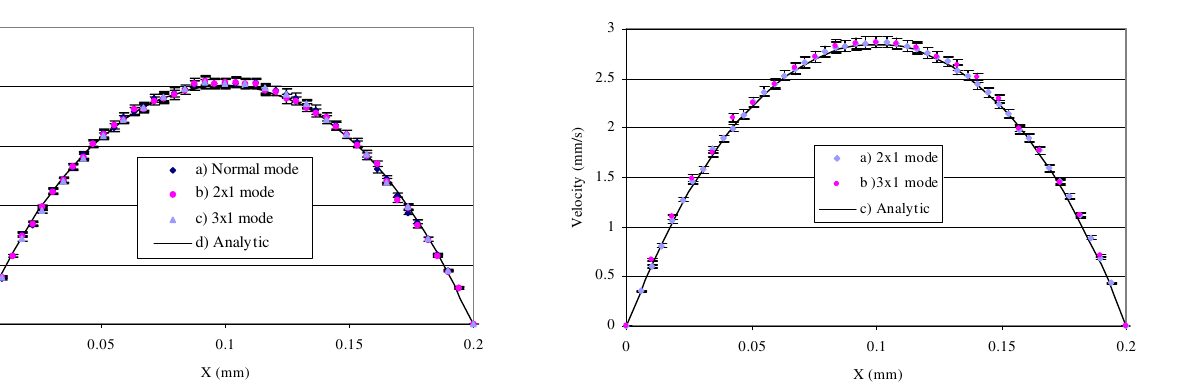
Fig. 5. (Color online) Velocity profiles (a) 2 × 1 vertical binning mode, (b) 3 × 1 vertical binning mode, (c) Solid curve depicts the analytically calculated velocity profile.